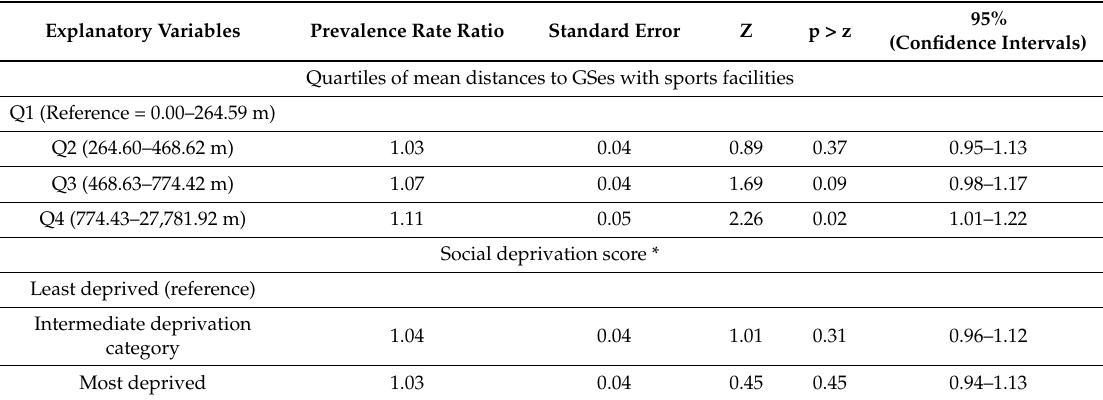
Table 2. Regression model of cerebrovascular prevalence and green spaces with sport facilities for adults ě 20 years living in Montreal and Quebec City CMAs,